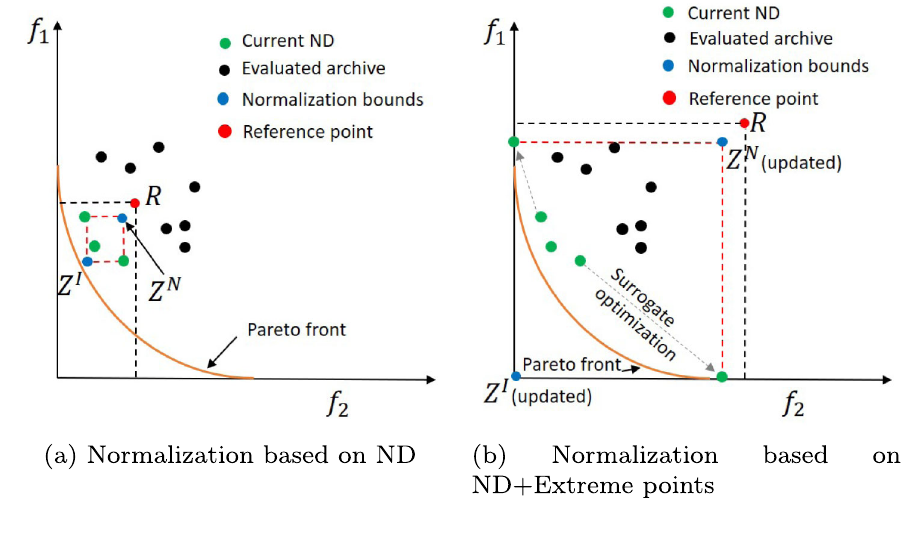
Fig. 1 Illustration of normalization